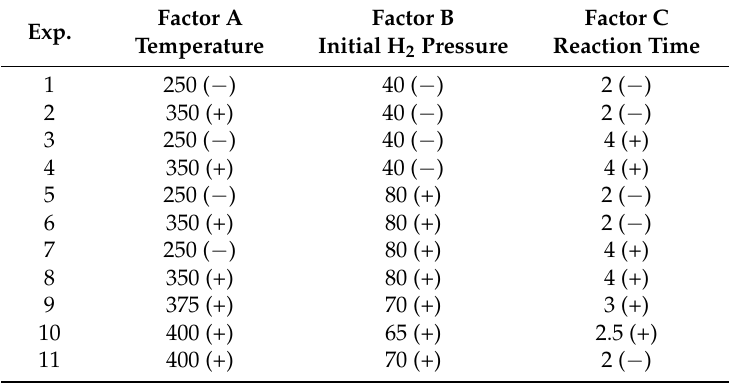
Table 3. Two-level factorial experimental matrix (1–8) along with three confirmatory experiments (9–11) at high temperatures.